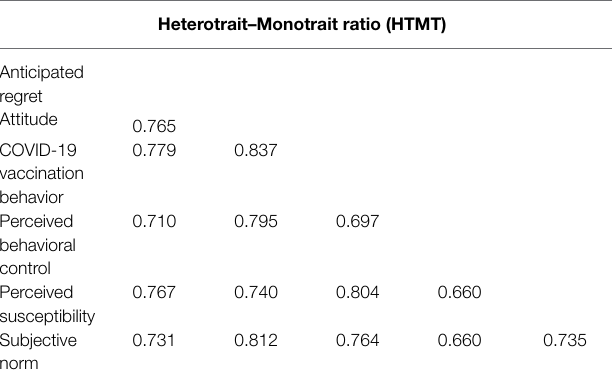
TABLE 4 | Assessment of discriminant validity ( n = 680).